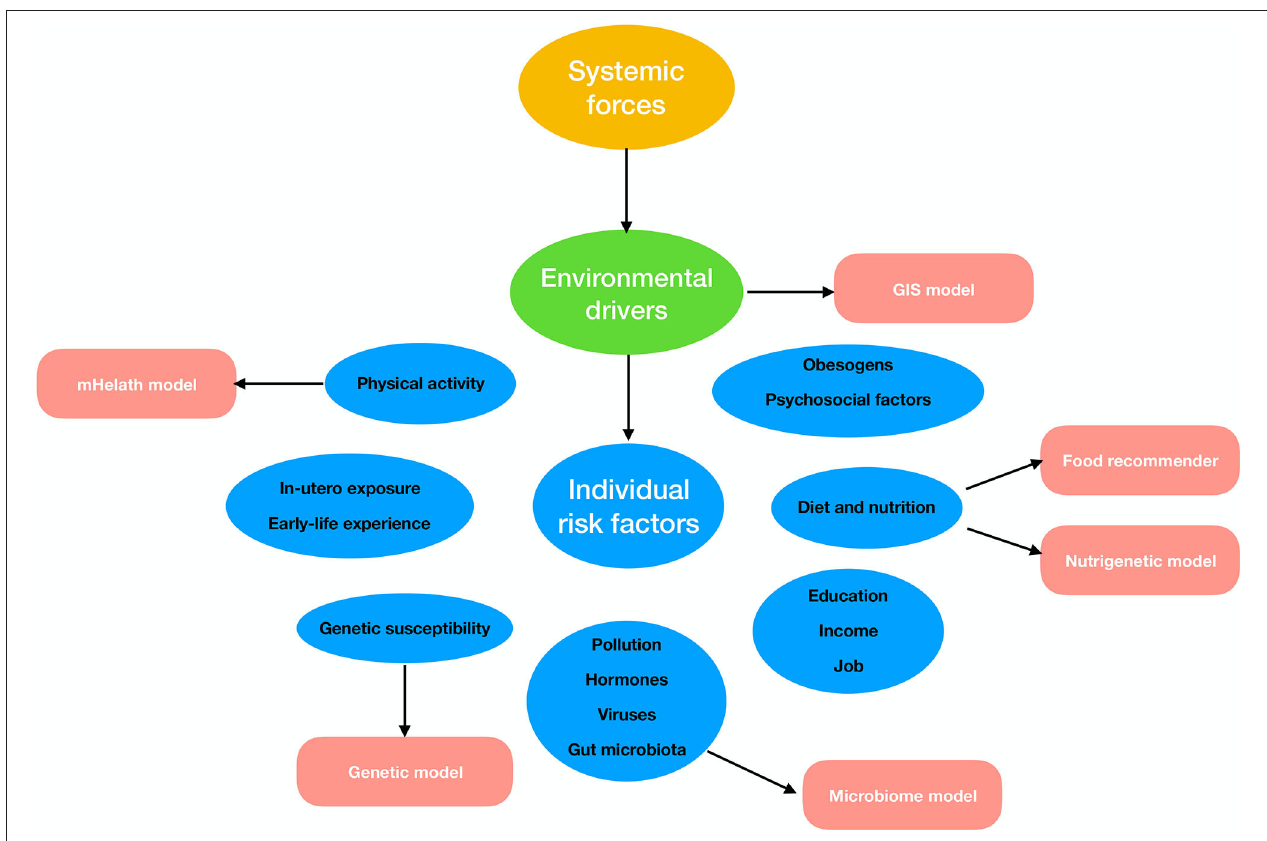
FIGURE 1 | Possible machine learning (ML) applications according to risk factors leading to obesity.